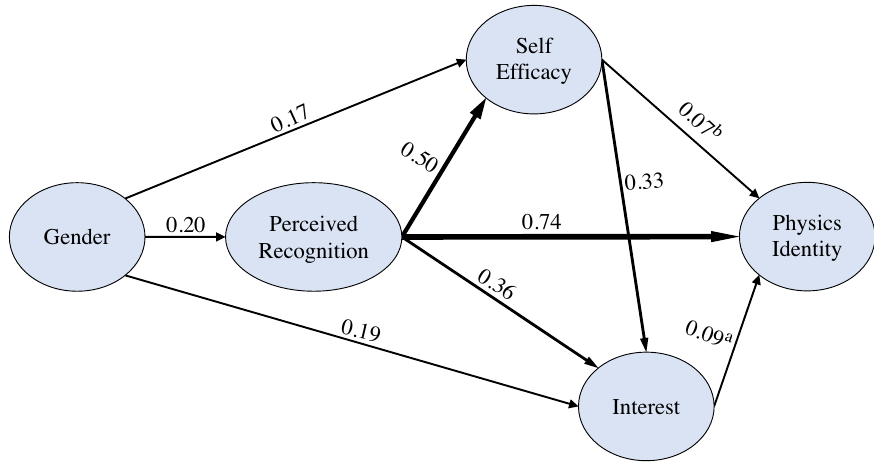
FIG. 2. Result of the path analysis part of the SEM with the relationship between gender and physics identity being mediated through perceived recognition, self-efficacy, and interest for physics 1. The gender variable was coded as 0 for women and 1 for men. The line thickness qualitatively denotes the relative magnitude of the standardized regression coefficients β shown. All p values for β are indicated by no superscript for p < 0 . 001 “ a ” for 0 . 001 ≤ p < 0 . 05 , and “ b ” for p ≥ 0 . 05 (nonsignificant). Gender does not directly predict physics